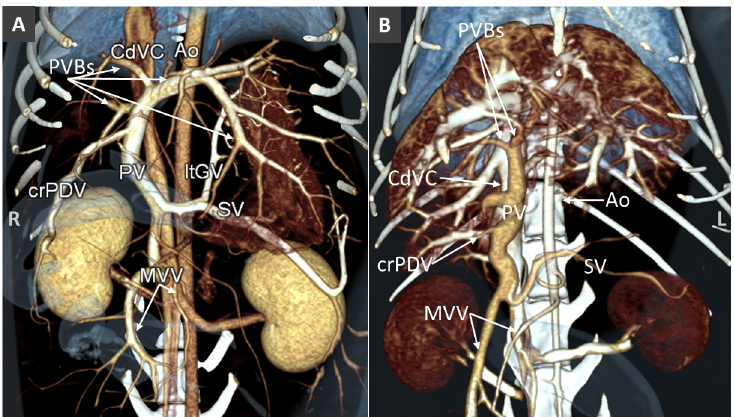
Figure 2. Volume rendered images (ventral views) of normal portal venous system in a dog ( A ) and a cat ( B ). Ao, aorta; CdVC, caudal vena cava; PVBs, portal vein branches; PV, portal vein; ltGV, left gastric vein; crPDV cranial pancreatic duodenal vein; SV, splenic vein; MVV, mesenteric veins.